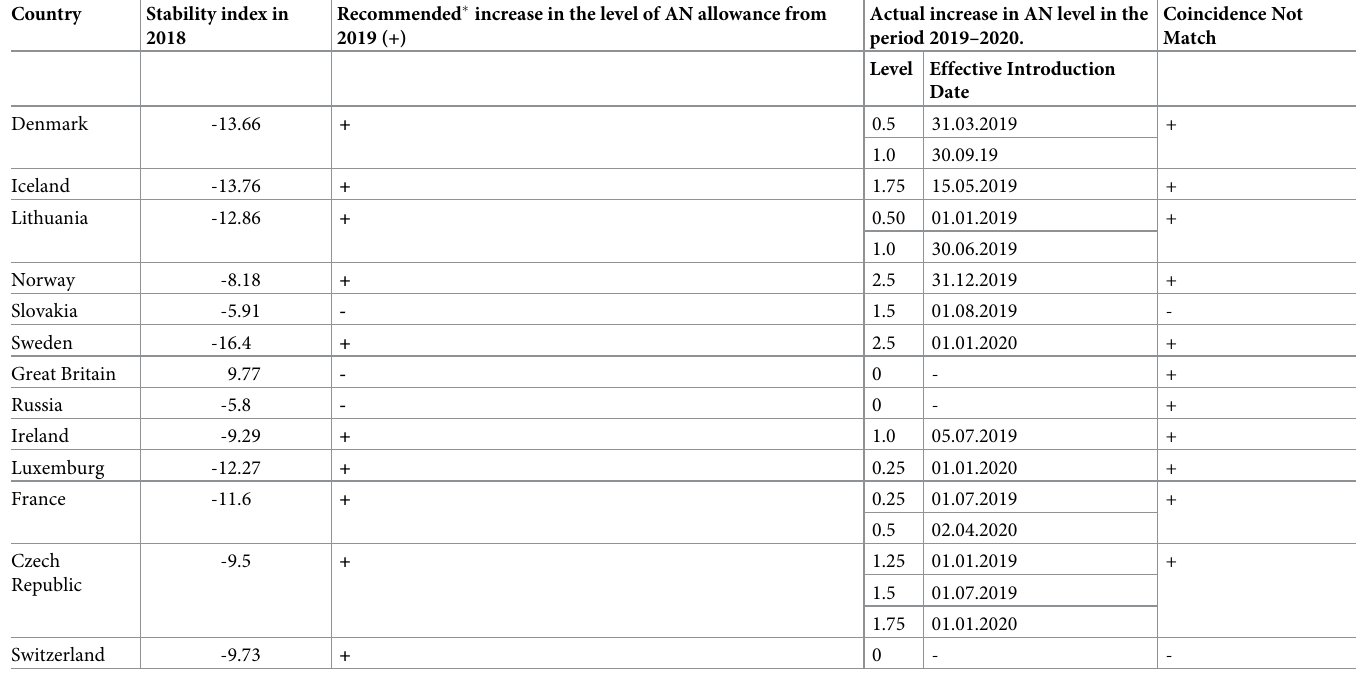
Actual increase in AN level in the period